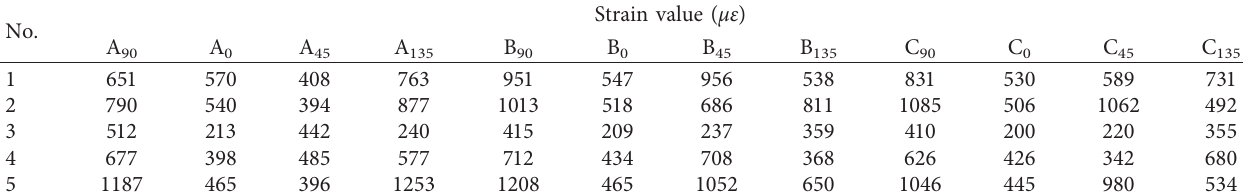
Strain value ( με )